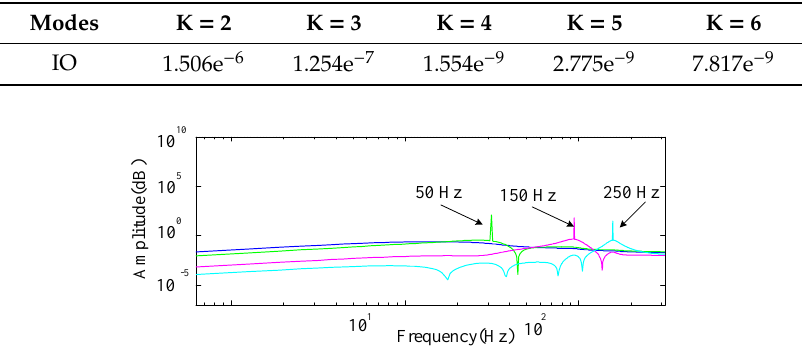
Figure 5. Spectrums of VMD-HT algorithm under K = 4 under noise-free situation.